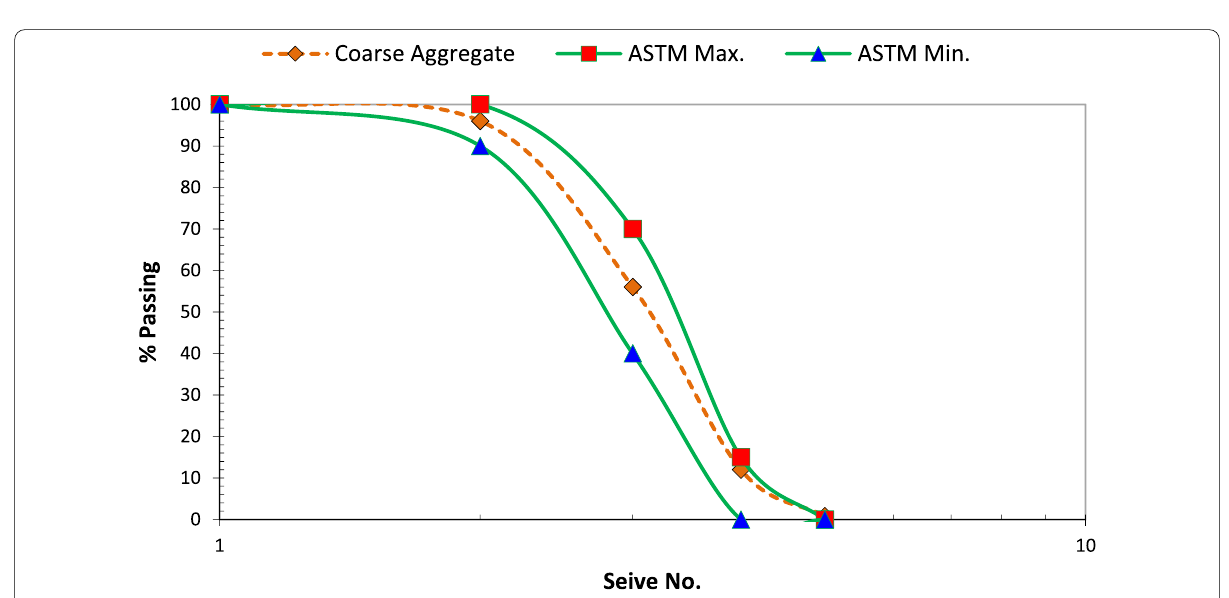
Fig. 3 Particle size distribution of coarse